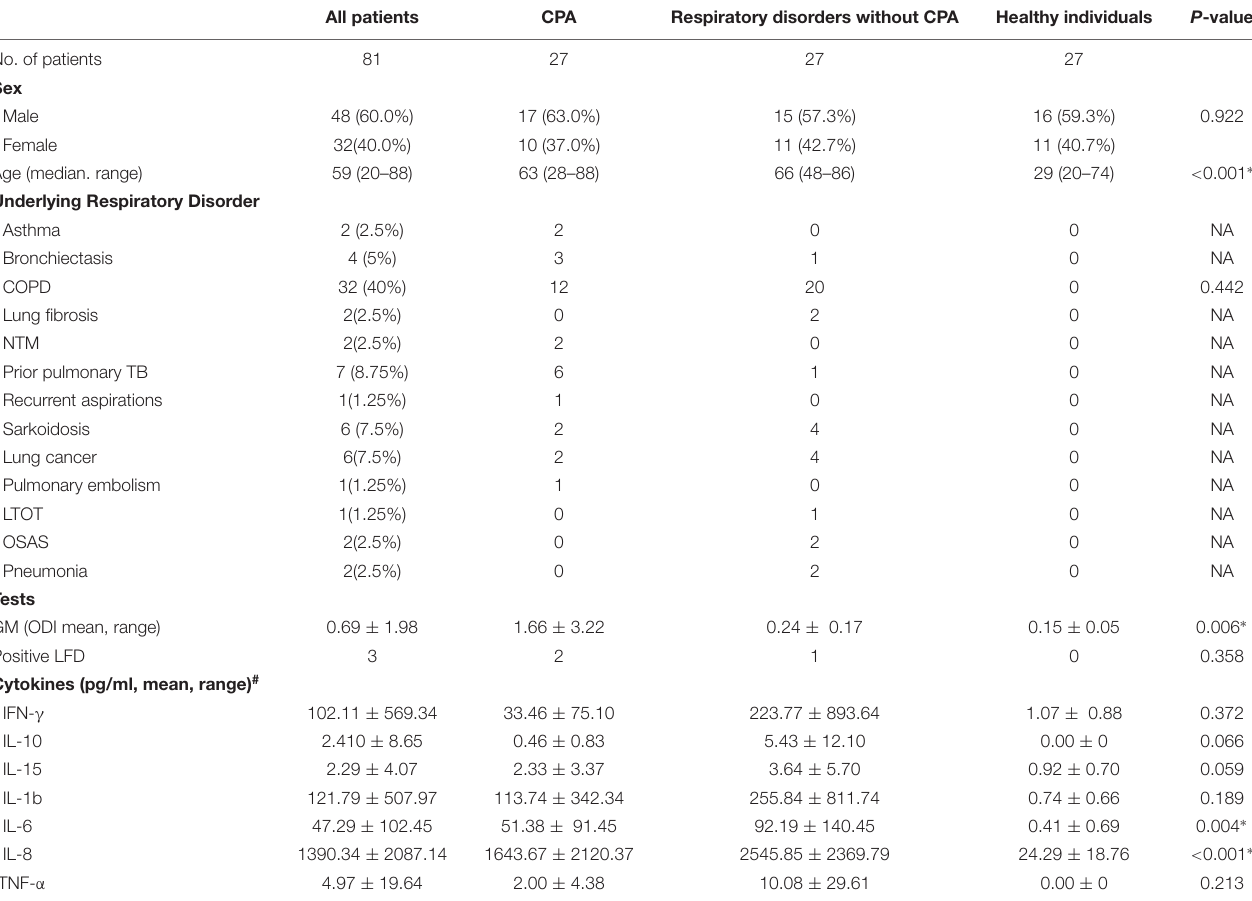
TABLE 1 | Demographic data, underlying respiratory disorders and mean values with standard deviations of GM, LFD, and cytokine levels. All